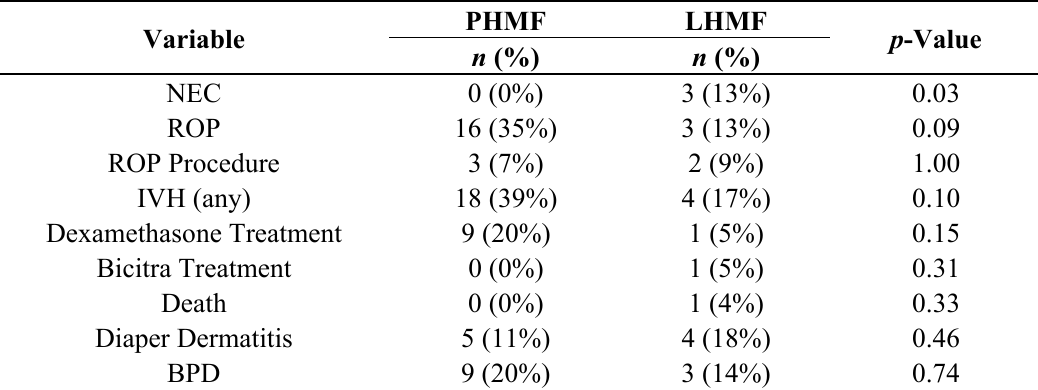
Table 4 . Clinical